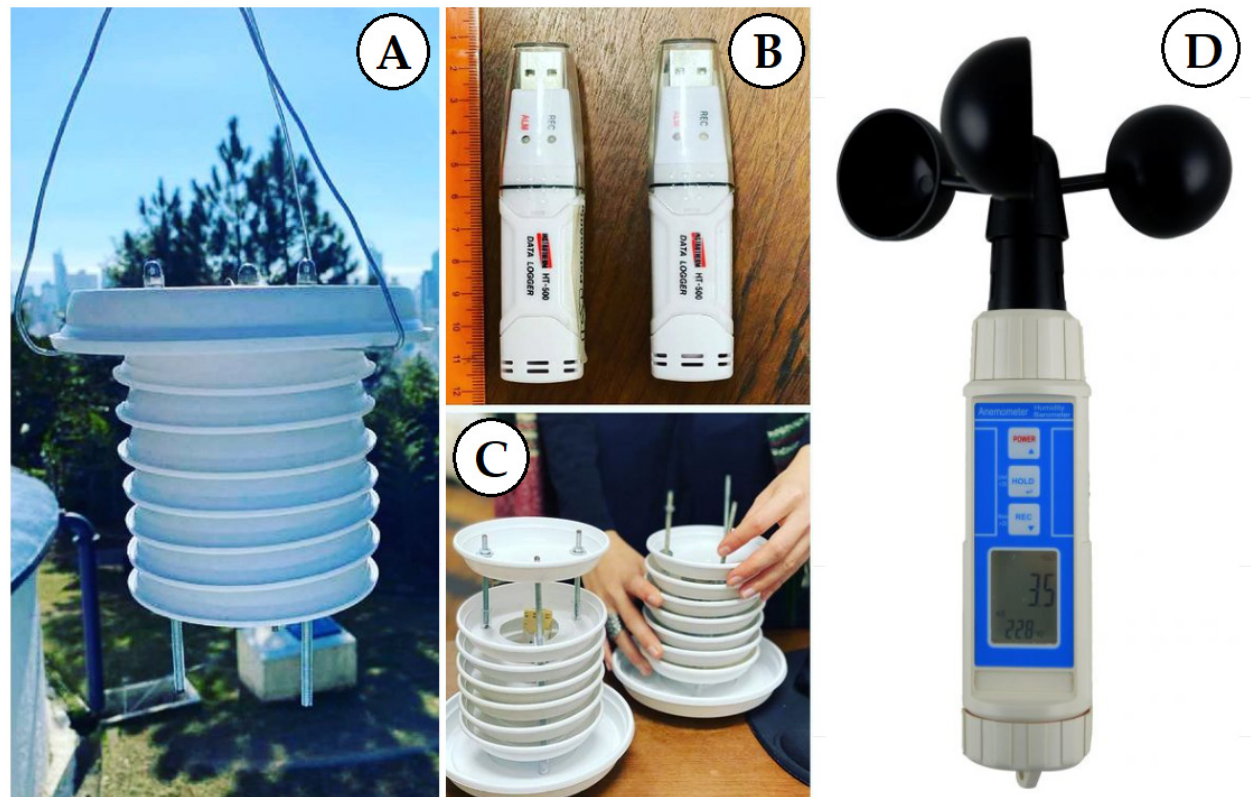
Figure 4. Meteorological shelter ( A ); dataloggers Instrutherm HT 500 ( B ); preparation of the meteorological shelter with the datalogger inside it ( C ); and the thermo ‐ hygro ‐ anemometer ‐ barometer ( D ).